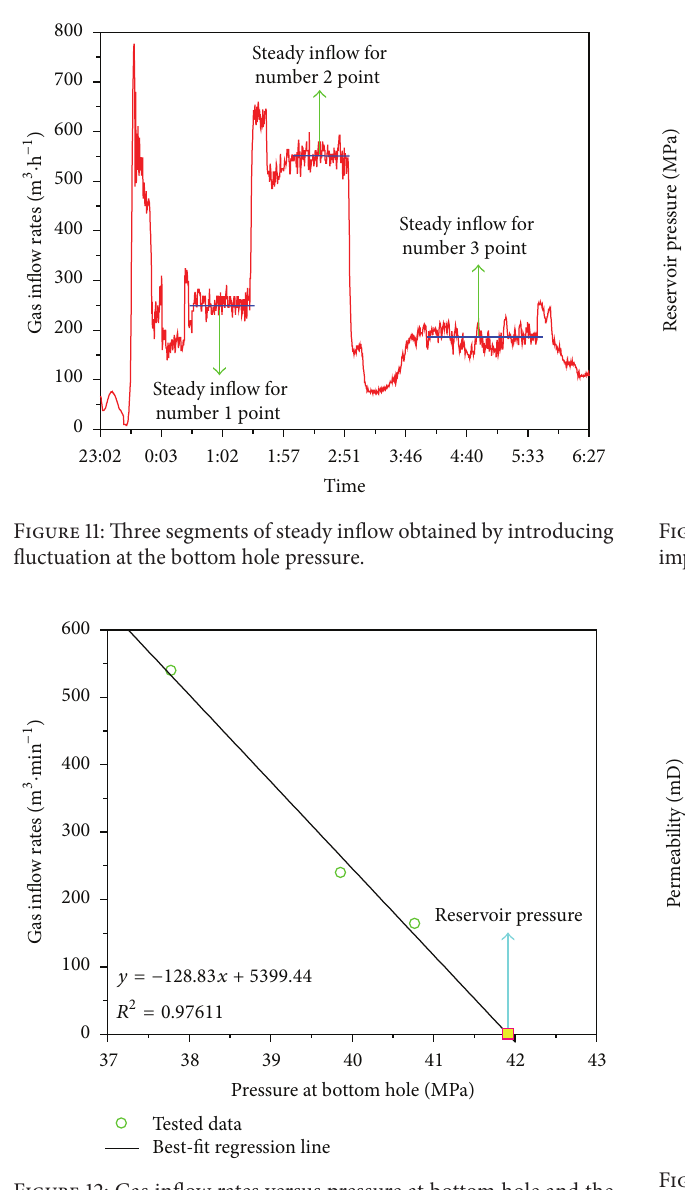
Figure 12: Gas inflow rates versus pressure at bottom hole and the best-fit regression line.